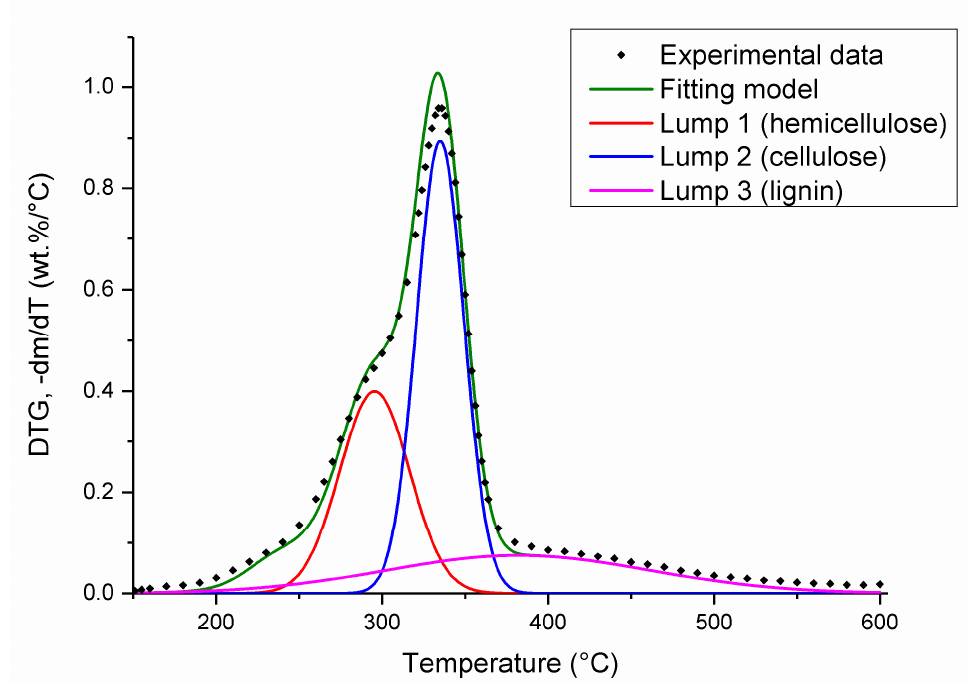
Figure 2. Deconvolution of DTG curve for Miscanthus giganteus at heating rate of β = 10 ◦ C/min. 250 Table 2. Parameters of deconvolution of DTG curves for energy crops. 251